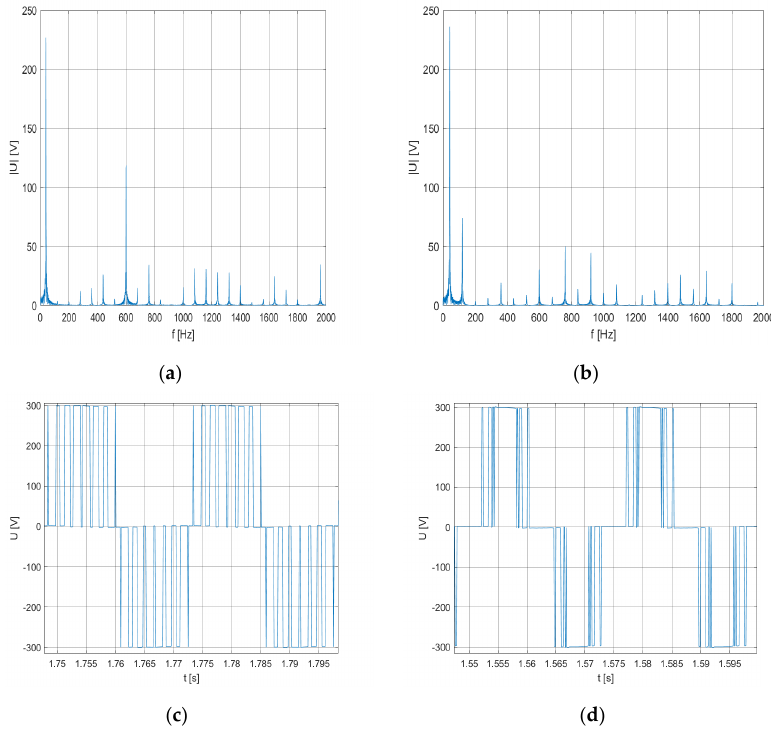
Figure 5. Comparison of the phase voltage waveform and spectrum of harmonics for the fundamental frequency of 40 Hz: ( a , c ) SCPWM method; ( b , d ) SHE method.